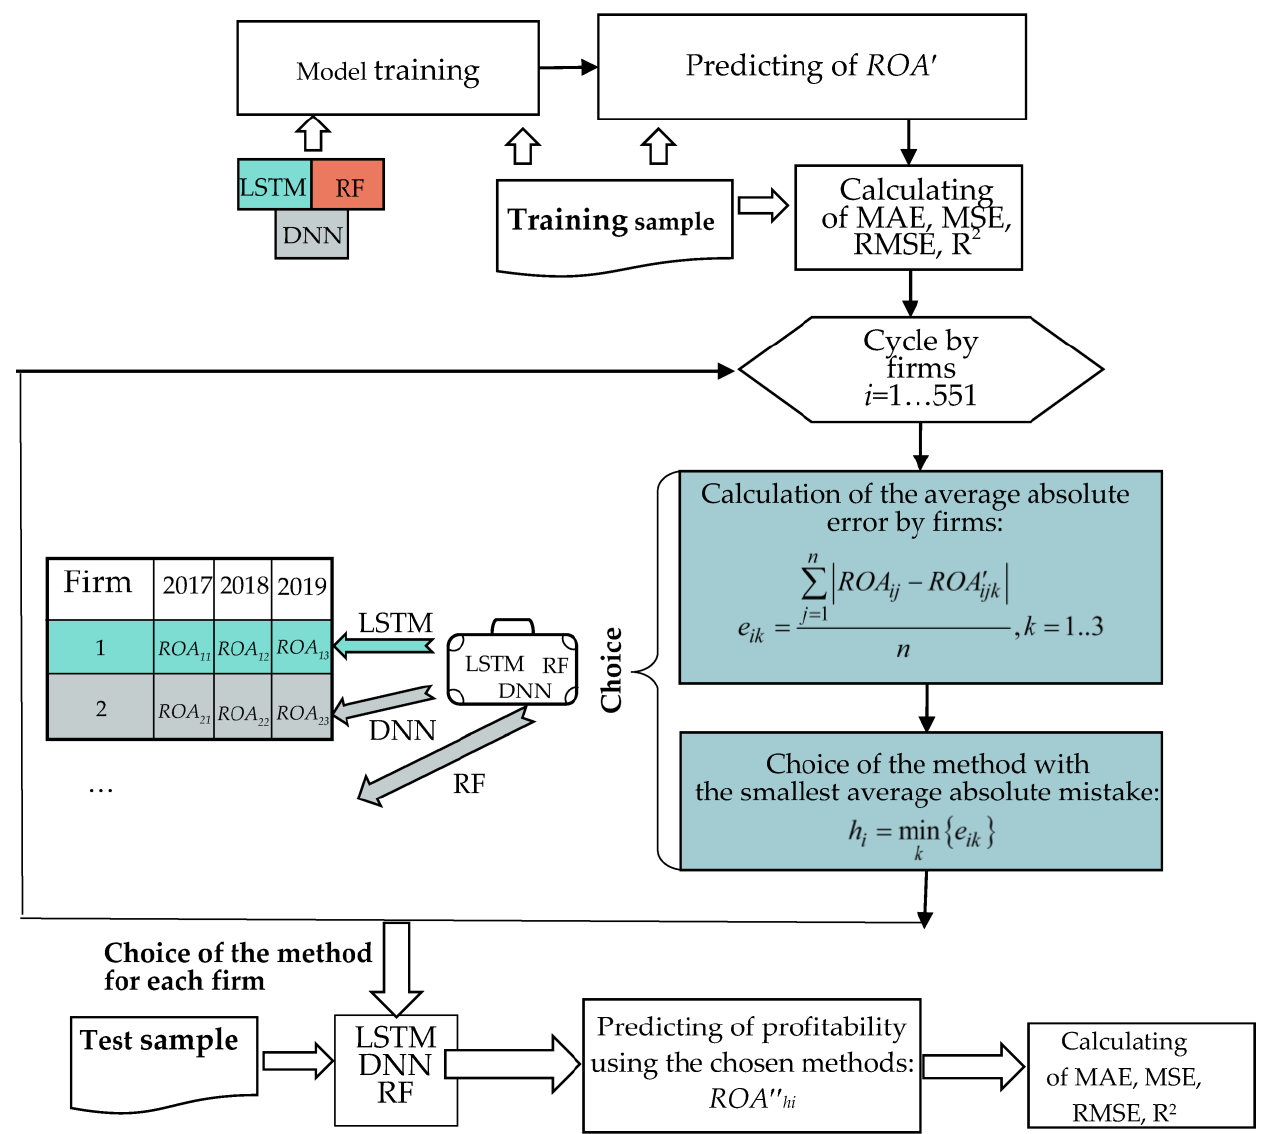
Figure 2. Forecast using a portfolio with minimization of training sample errors.